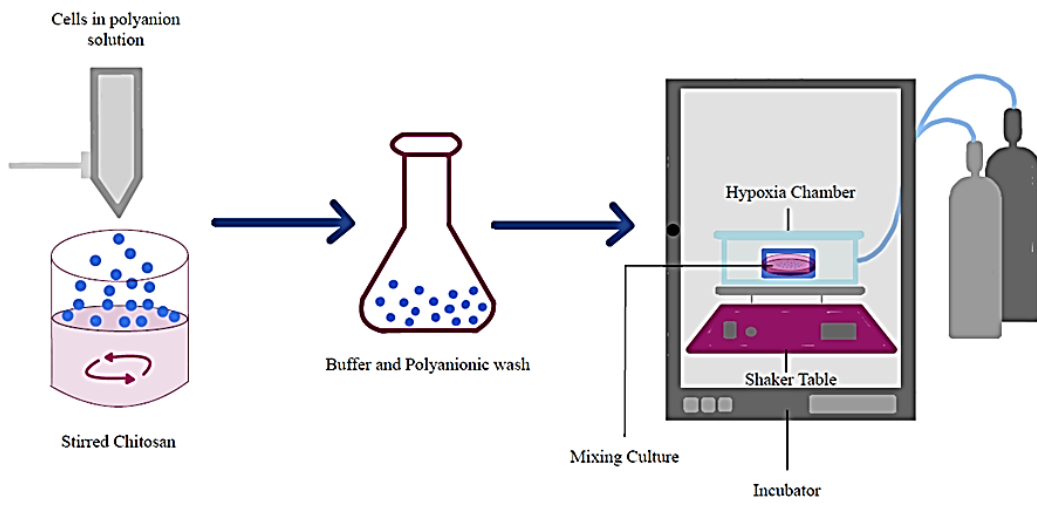
Figure 4. Diagram of the encapsulation culture process.